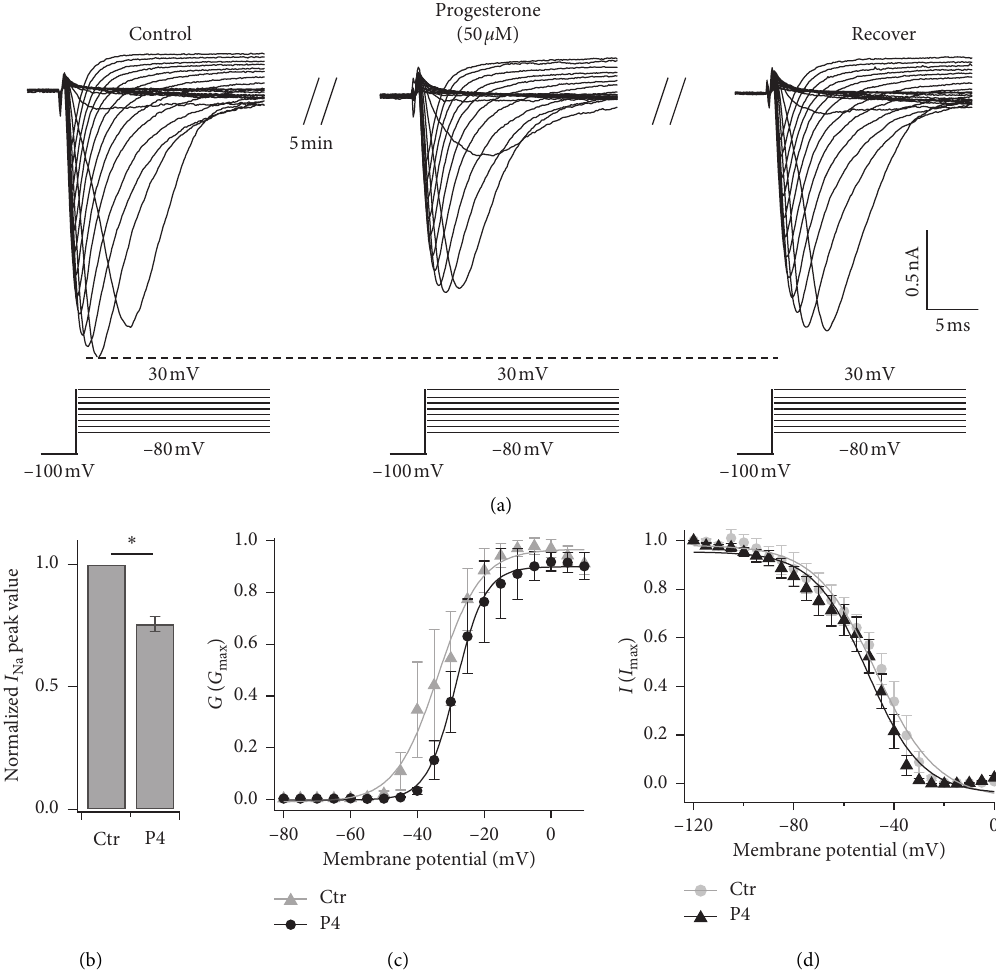
Figure 3: Progesterone attenuated sodium currents in freshly isolated TG neurons. (a) Representative traces showing that extracellular application of progesterone (P4, 50 µ M) decreases sodium currents after 5min reversibly in freshly isolated TG neurons in response to 50ms depolarization from − 80mV to 30mV from an holding potential of − 100mV with an increment of 5mV every 5s. (b) Statistical data showing that 5min treatment with P4 (50 µ M) attenuate the peak value of sodium currents ( n � 6) in freshly isolated TG neurons. ∗ P < 0 . 05 versus the control group. (c) The voltage-dependent activation curve of sodium channels in TG neurons before and after P4 application. (d) The steady-state inactivation curve of sodium channels in TG neurons before and after P4